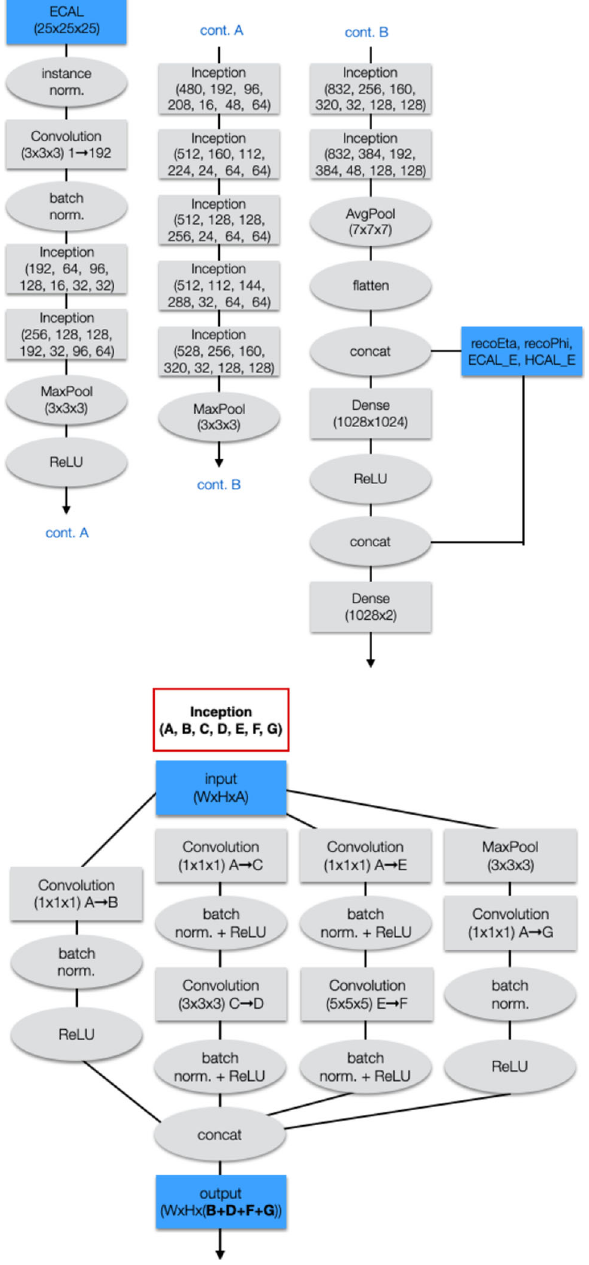
Fig. 29 GoogLeNet-basedarchitecture(top)andcomponentinception architecture